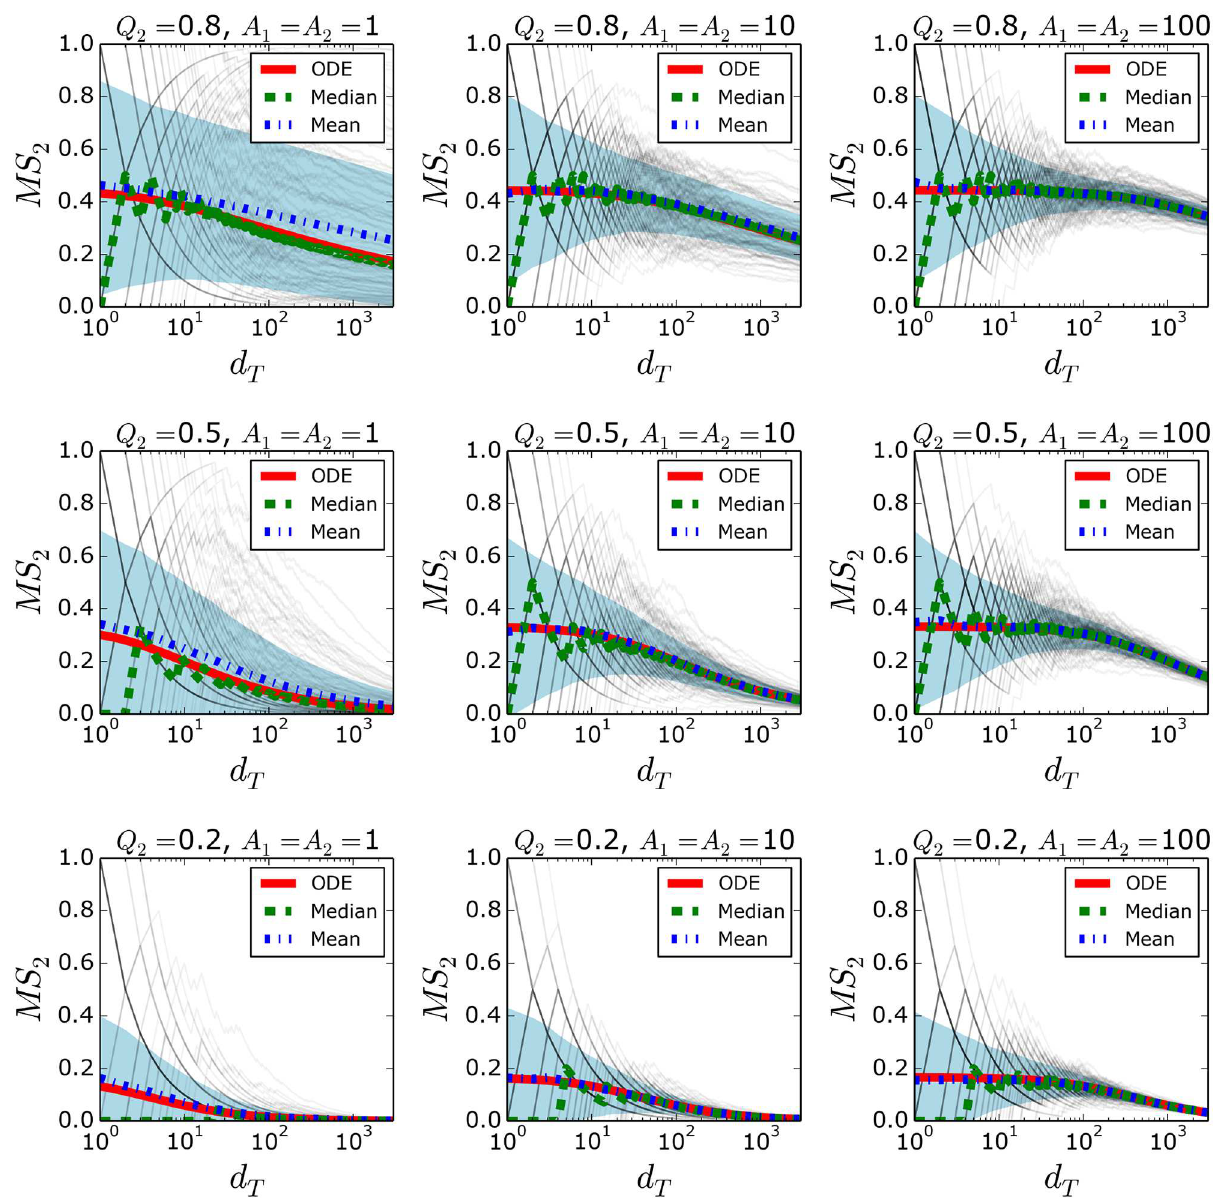
Fig 2. Monte Carlo simulations and ODE solutions of the marketshares for symmetric appeals. The Monte Carlo simulations involved10 4 realizationsof the system for nine different set of parameters (grey lines). In all cases we used q 1 = 1, the appealused for both products were the same ( A 1 = A 2 ) and both products start with zero purchases, d 1 ( t = 0) = d 2 ( t = 0) = 0. Although the Monte Carlo simulations producediscrete dots in the ( d T , MS 2 ) space, we plot each simulationwith straight lines that link consecutive dots to follow trajectorieseasily.